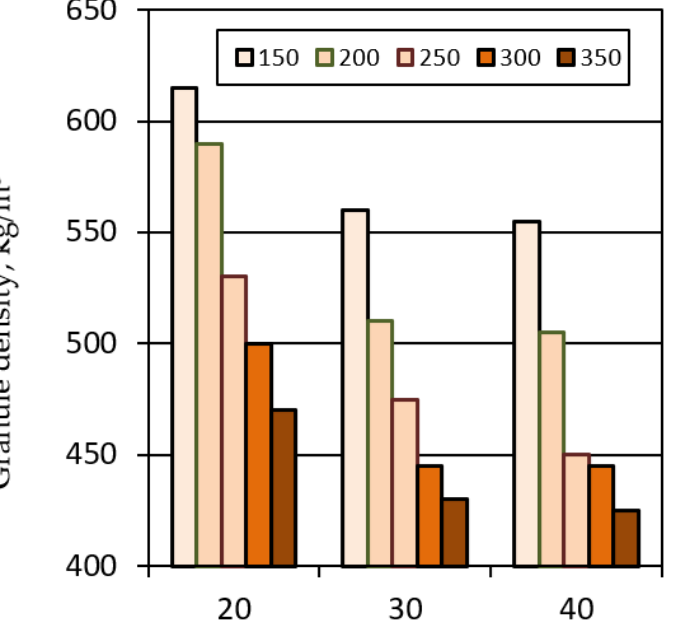
Figure 6. Effect of firing temperature and filler composition on the density of liquid glass granules.